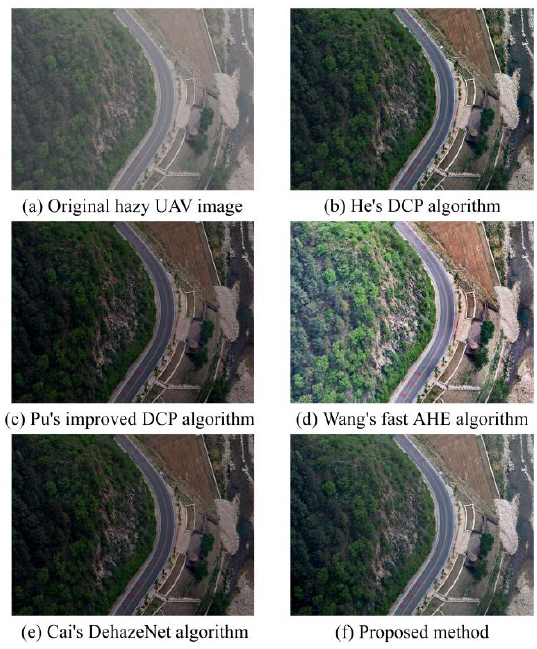
Figure 4. Comparison of different methods on images of buildings: (a) Original hazy UAV image. (b) He's Dark Channel prior algorithm. (c) Pu's Improved DCP algorithm. (d) Wang's fast adaptive histogram equalization algorithm. (e) Cai's DehazeNet algorithm. (f) Proposed method